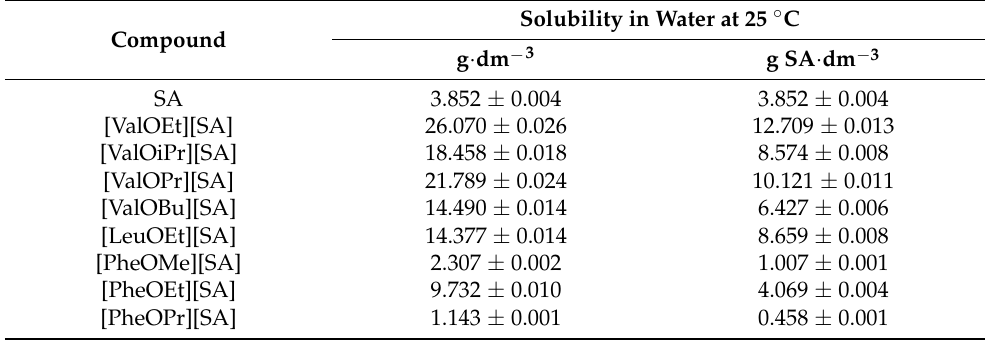
Table 2. The solubility of salicylic acid and L-proline alkyl ester naproxenates in water at 25 ◦ C. Compound